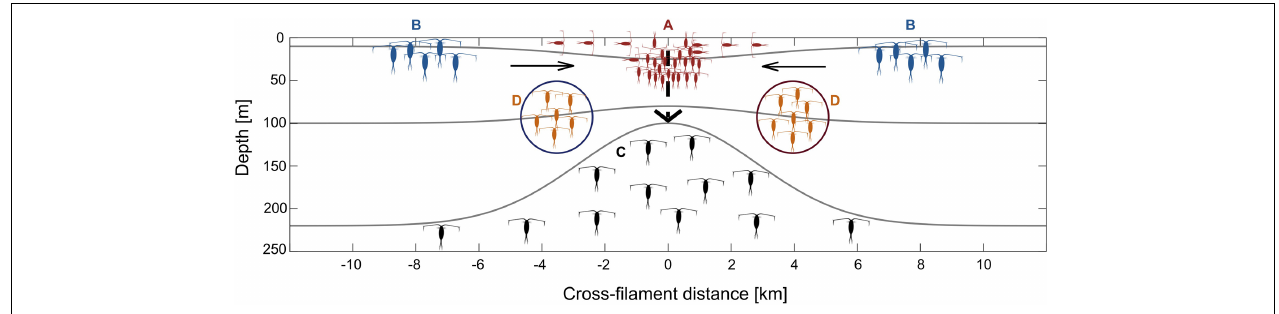
FIGURE 7 | Schematic illustration of the effects of a submesoscale filament on zooplankton dynamics in the Arctic marginal ice zone. Colors of copepods represent different distribution patterns, i.e., red: convergence of surface species at the filament center (Group A), blue: concentration of Arctic species in Polar Surface Water at the outer stations (Group B), black: emergence of mesopelagic species by isopycnal doming/upwelling (Group C), orange: species in along-frontal jets (Group D).